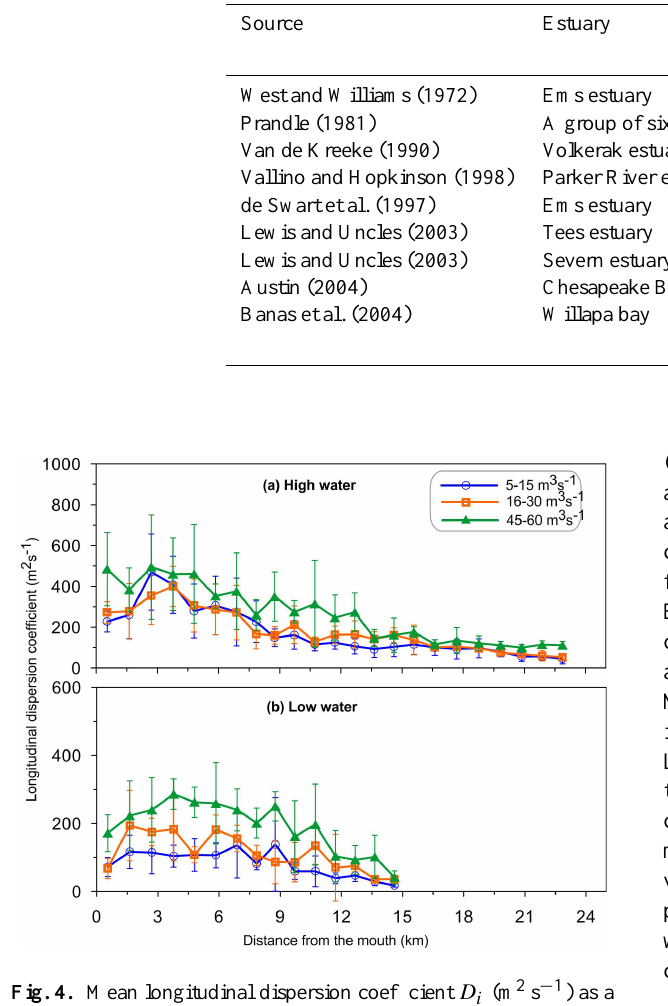
Fig. 4. Mean longitudinal dispersion coefficient D i (m 2 s − 1 ) as a function of position along the Sumjin River Estuary for high water slack and low water slack conditions.